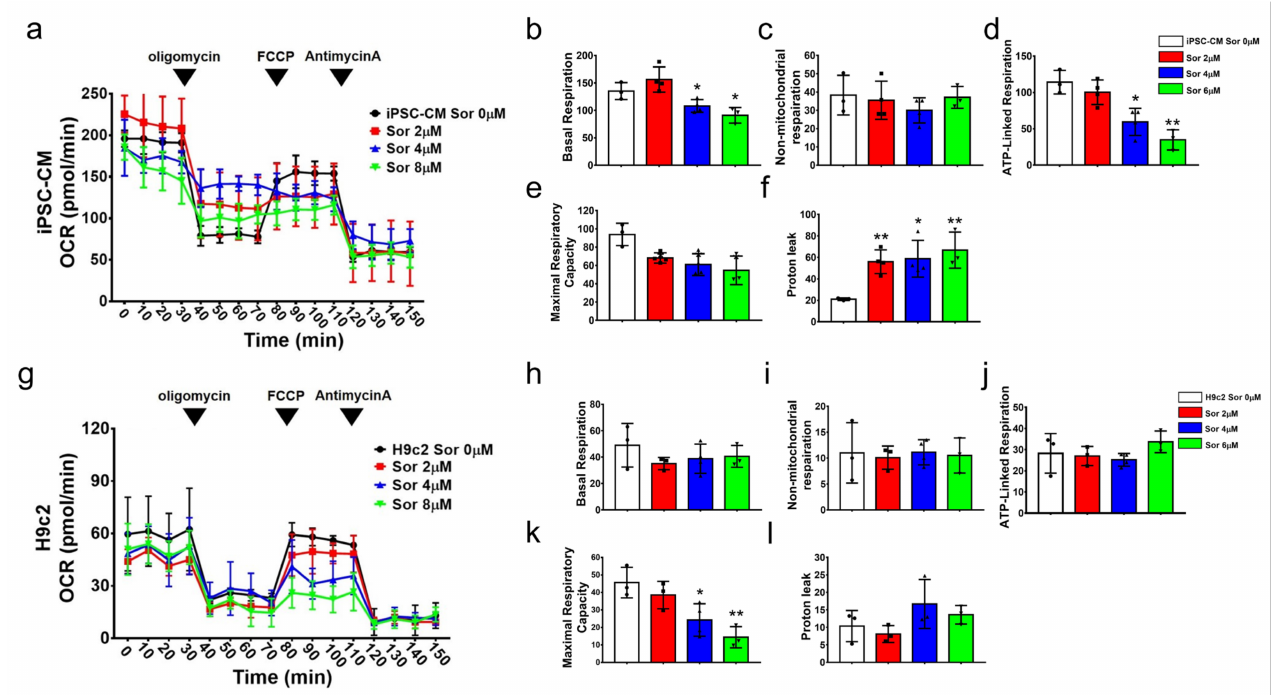
Figure 3. Bioenergetic parameters in hiPSC-derived cardiomyocytes and H9c2 cells. iPSC-CMs ( a – f ) and H9c2 cells ( g – l ) under 0, 2, 4, and 8 µ M sorafenib treatment for 24 h. Idealized bioenergetic profiling trace demonstrating oxygen consumption rate (OCR) ( a , g ), basal respiration ( b , h ), nonmitochondrial oxygen consumption( c , i ), ATP production ( d , j ), Maximal Respiratory Capacity ( e , k ), and proton leak ( f,l ). Each data points represent the mean ± SEM ( n = 3). p -values: * p < 0.05, ** p < 0.01 compared with 0 µ M sorafenib